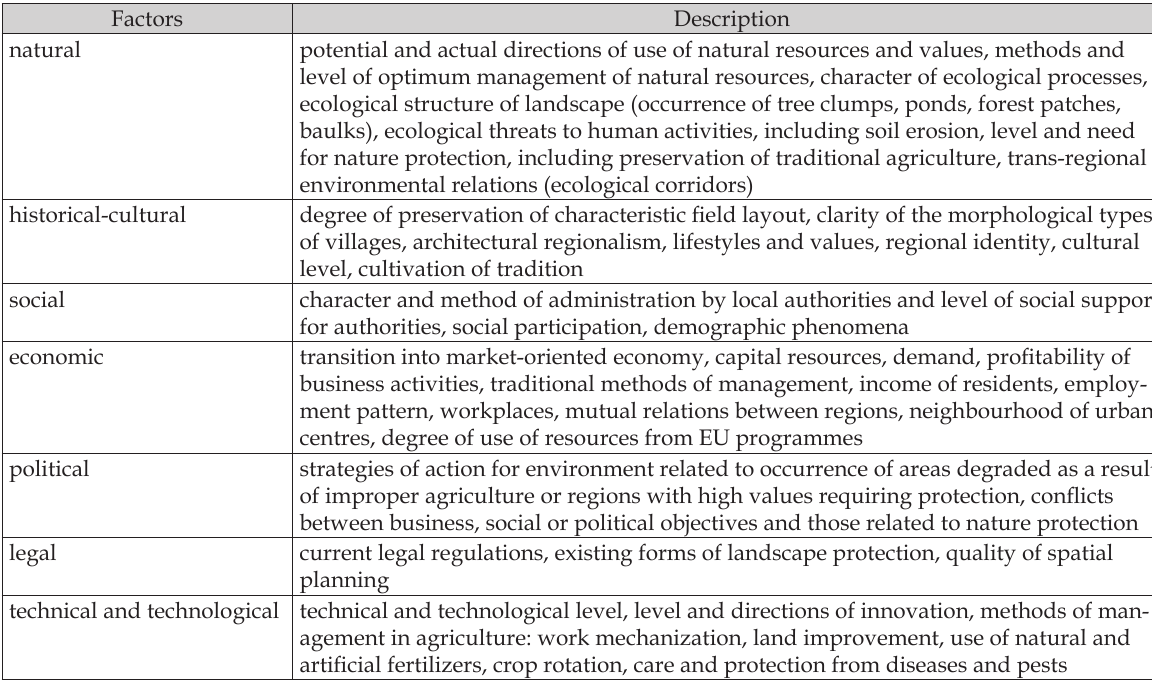
Table 2. Important factors for planning rural landscape